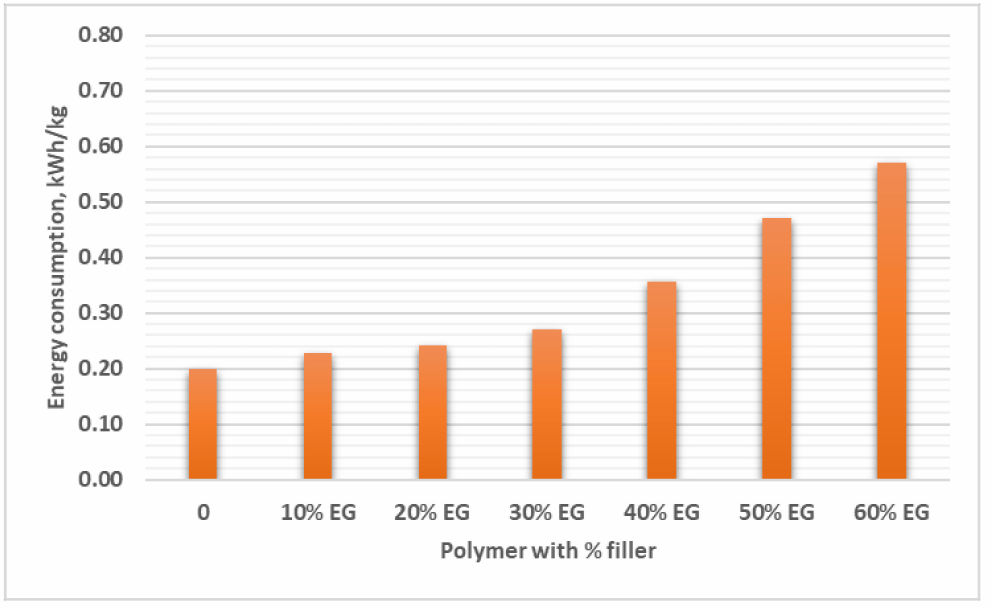
Figure 4. Energy consumption of the extrusion